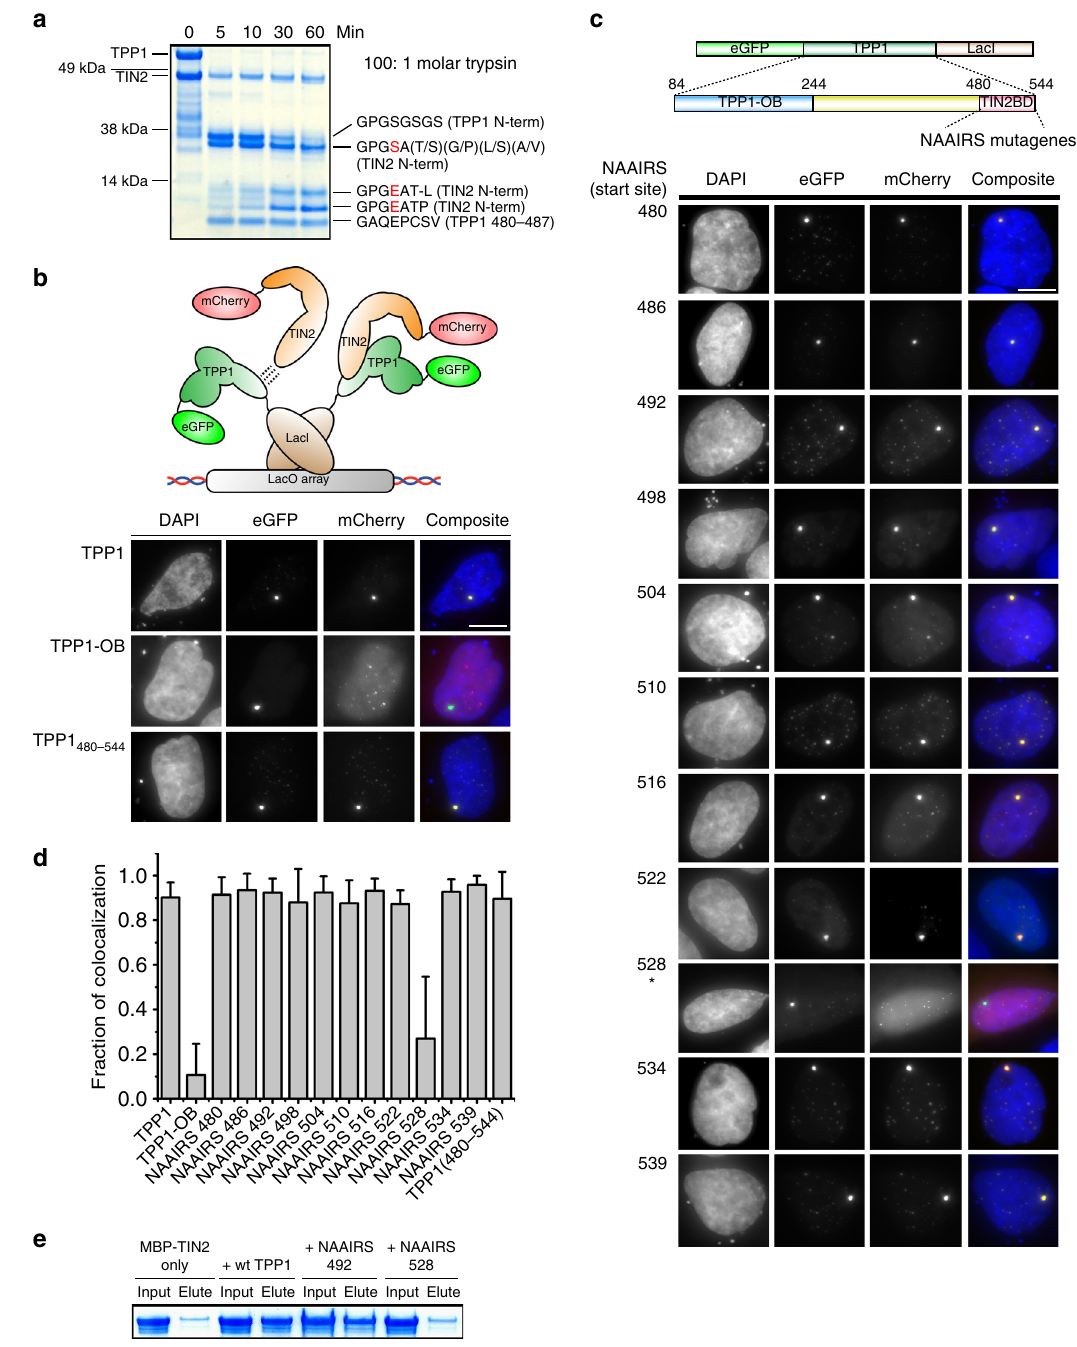
Fig. 5 Identi fi cation of a TPP1 region critical and suf fi cient for TIN2 interaction. a Trypsin limited proteolysis of TIN2 – TPP1 complex and peptide